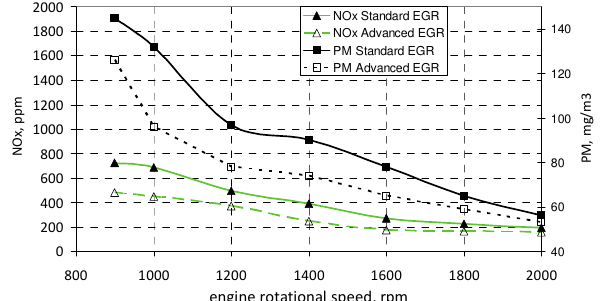
Fig. 28. Comparison of EGR cooling systems and NO x and PM concentra- tion at exhaust gasses